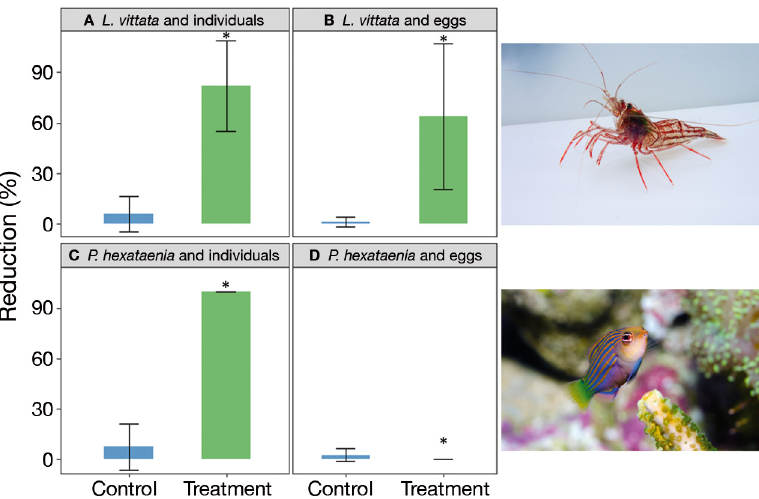
Fig. 1. Proportion of Acropora -eating flatworm individuals and egg capsules removed (error bars: ±SD) in the presence and absence of biocontrols. (A) Lysmata vittata and flatworm individuals (n = 24), (B) L. vittata and flatworm eggs (n = 20 egg clusters), (C) Pseudocheilinus hexataenia and flatworms (n